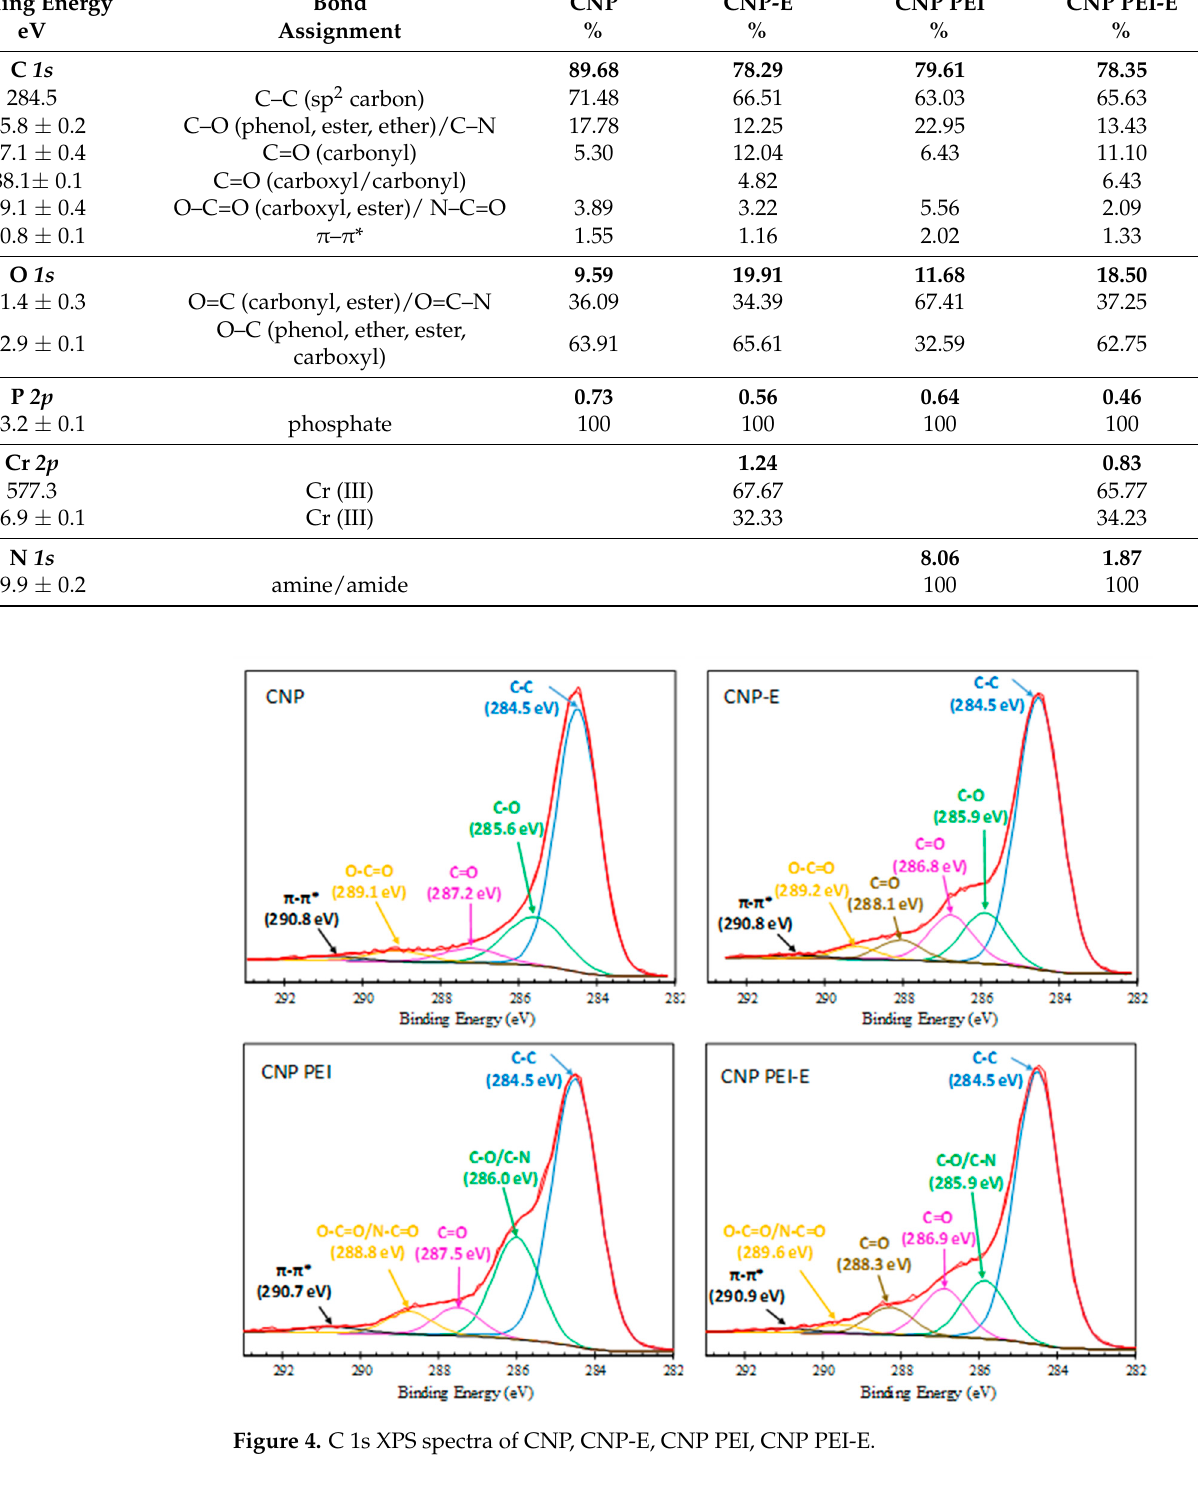
Figure 5. O 1s XPS spectra of CNP, CNP-E, CNP PEI, CNP PEI-E.